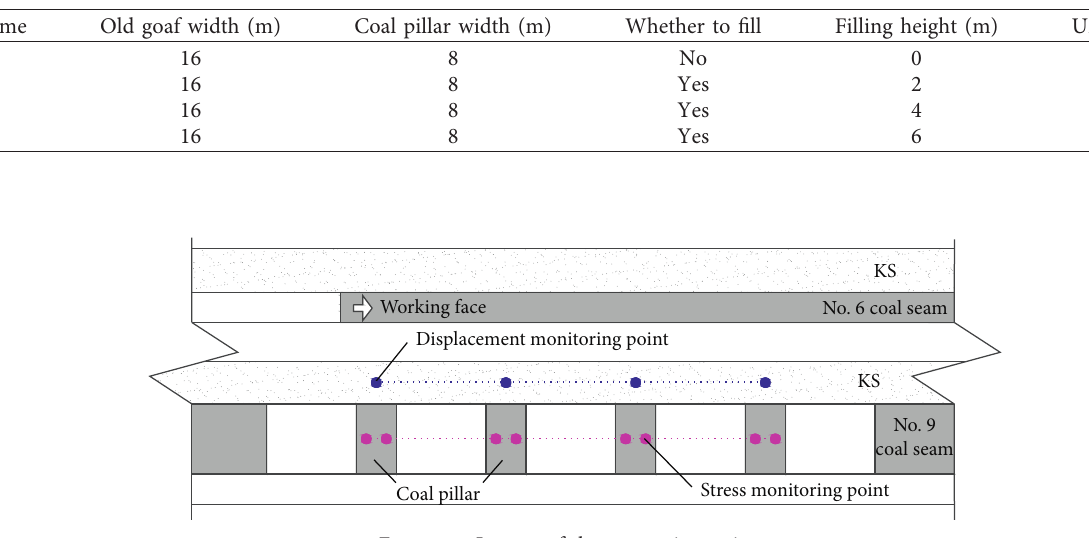
Figure 5: Layout of the measuring points.